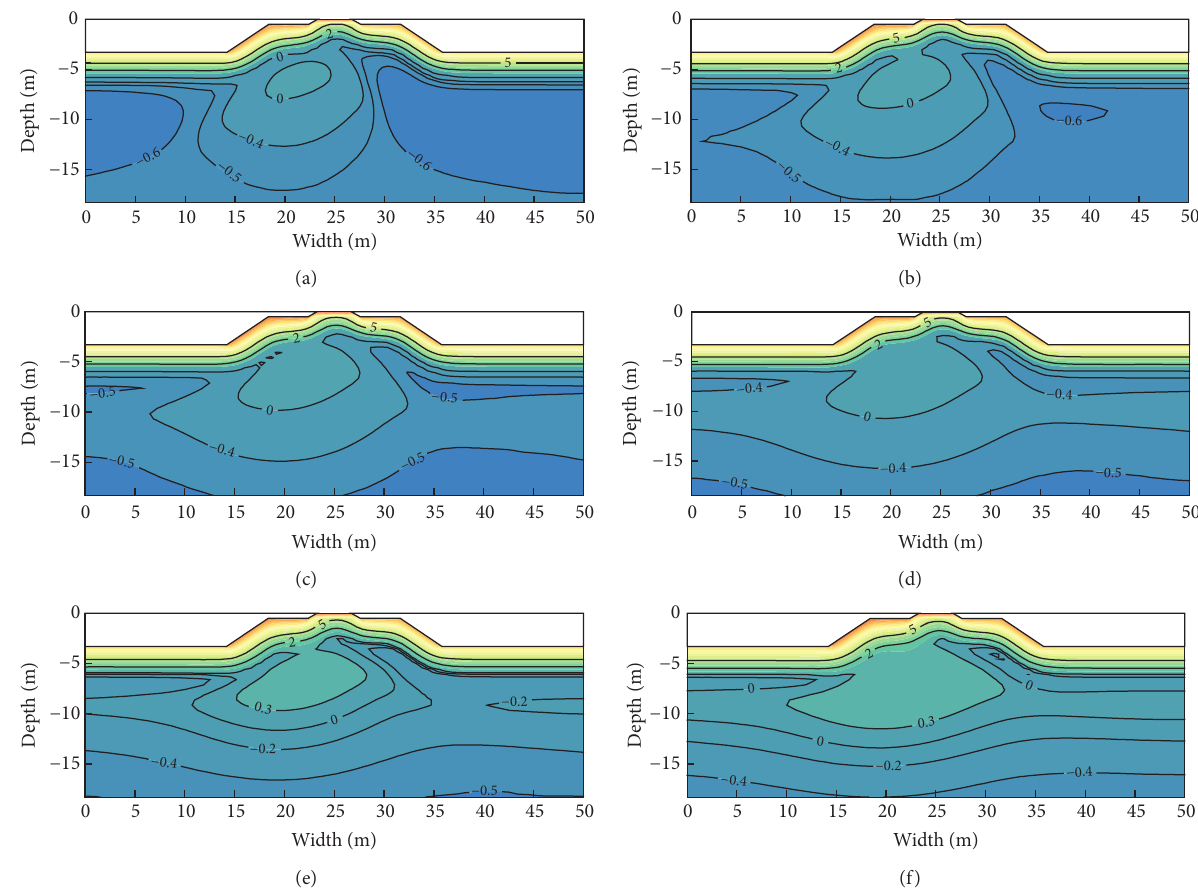
Figure 9: Simulated ground temperature distribution of embankment (unit: ° C). (a) 2022/7/1. (b) 2027/7/1. (c) 2032/7/1. (d) 2042/7/1. (e) 2037/7/1. (f)